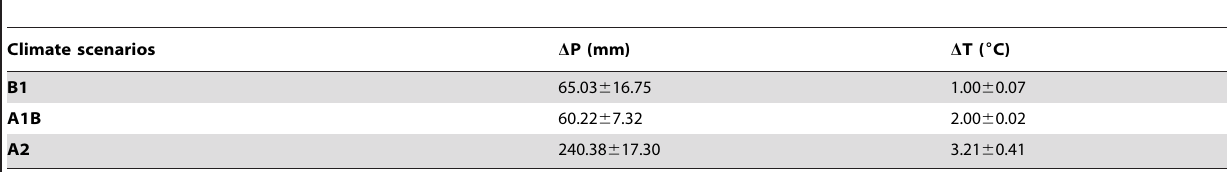
Table 2. The variation values of average annual precipitation and temperature in 2100 modeled by CGCM3.